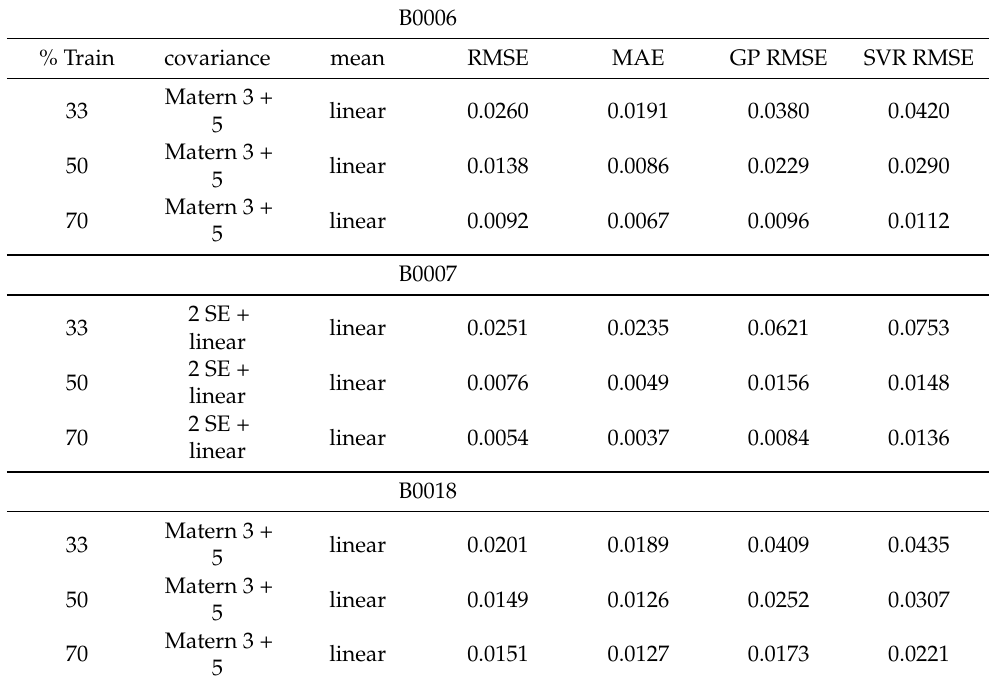
Table 1. RMSE and MAE for the prediction of the SOH for different training point numbers, % Train (percentage of the total). The results are also shown for a GP model without using the predicted features and for